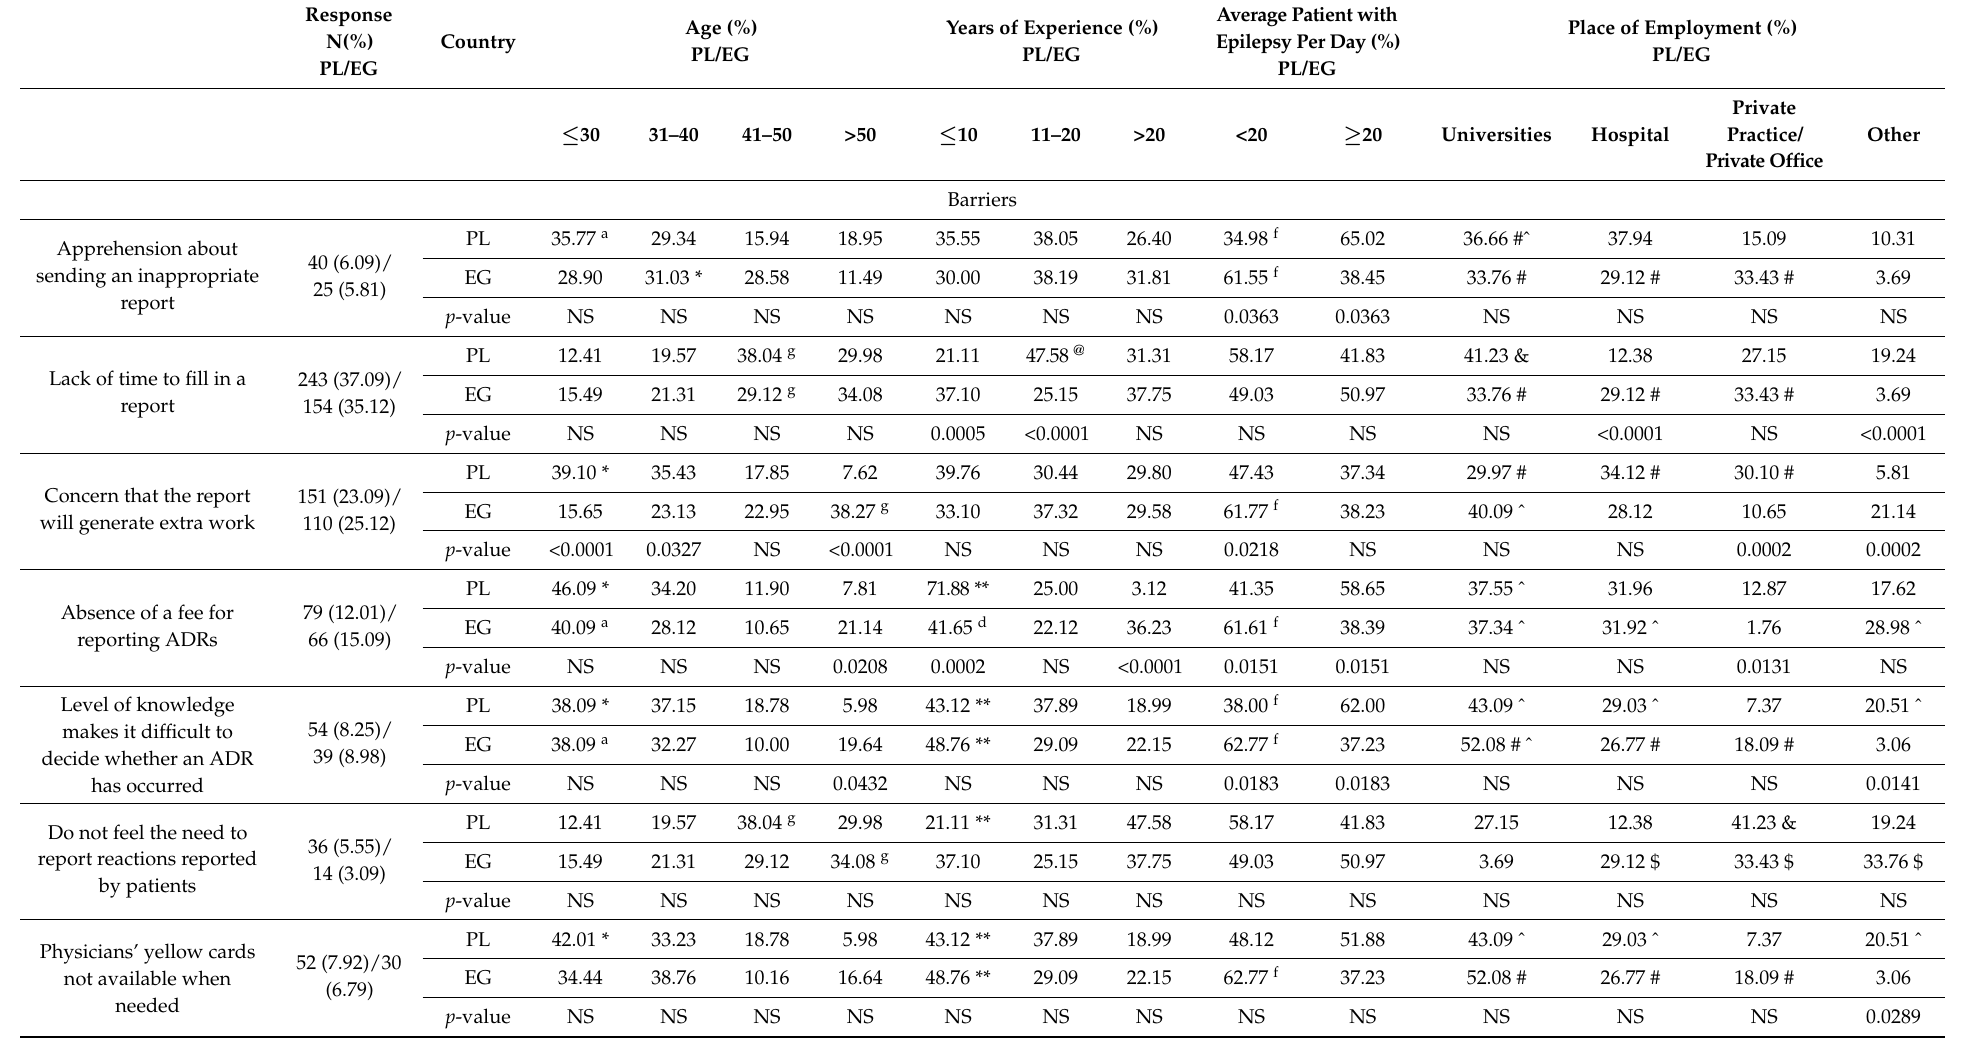
Table 3. The factors that may discourage neurologists from delivering pharmacovigilance and activities to improve spontaneous ADR reporting ( n =